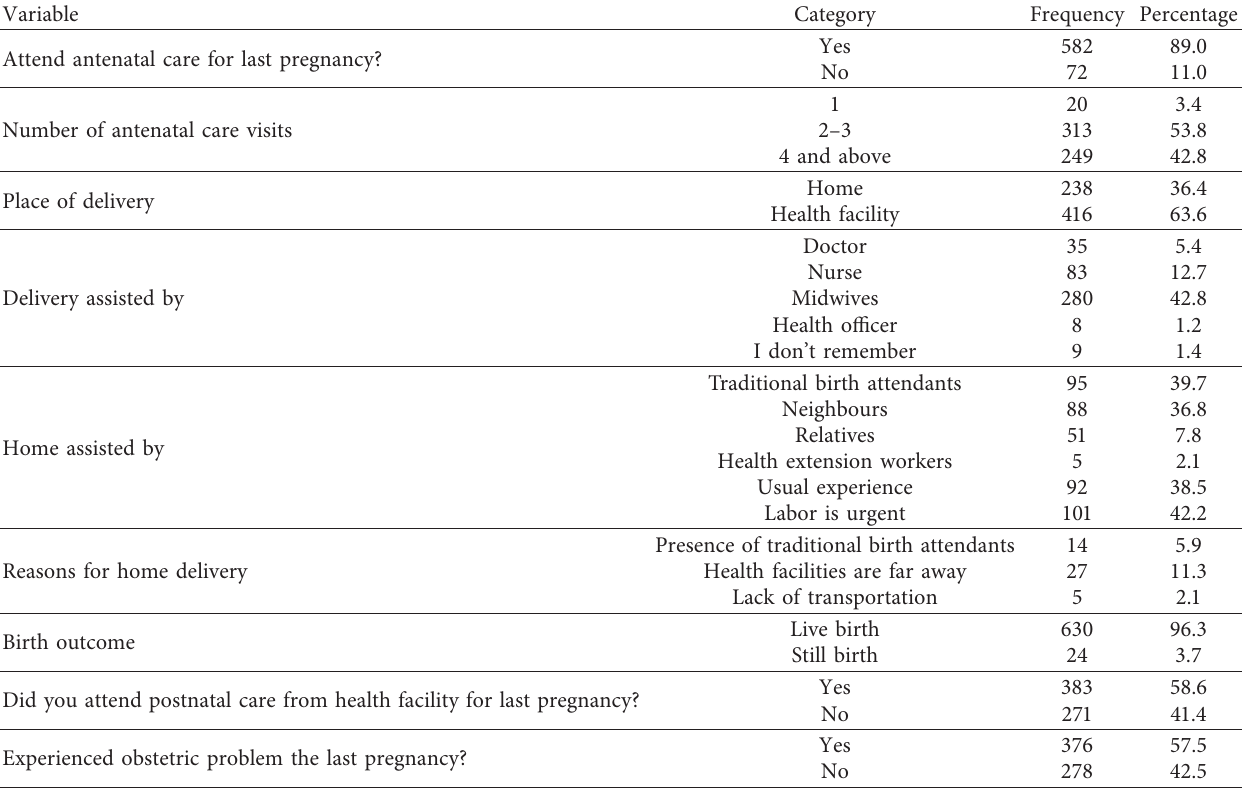
Table 4: Practice towards skilled maternal healthcare among study participants.